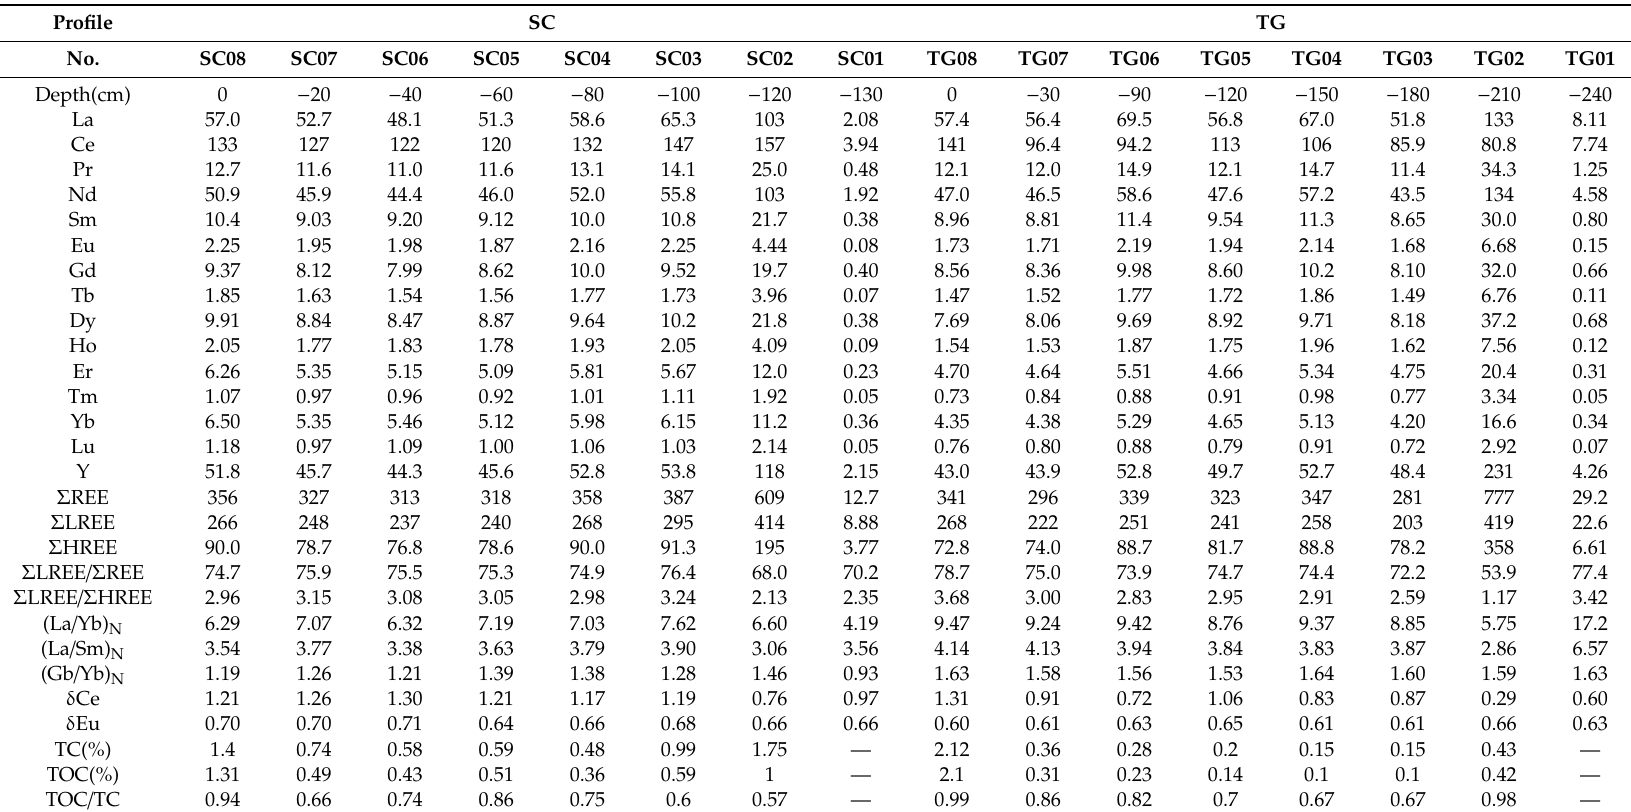
Table 2. The rare earth element (REE) concentration (ppm) and the parameters in bulk samples from the SC and TG profiles *.